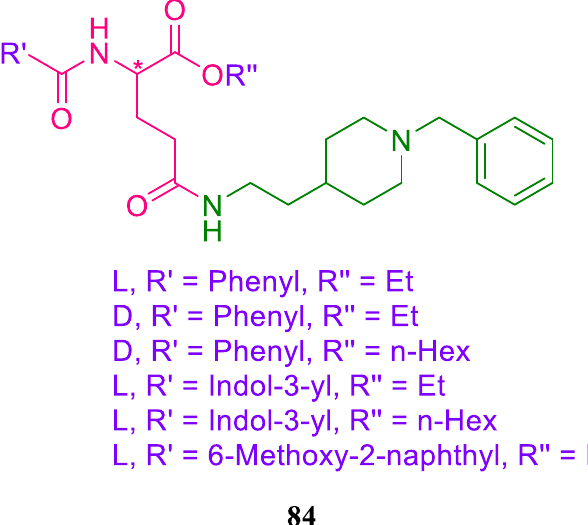
Figure 68. D - and L -Glu derivatives having